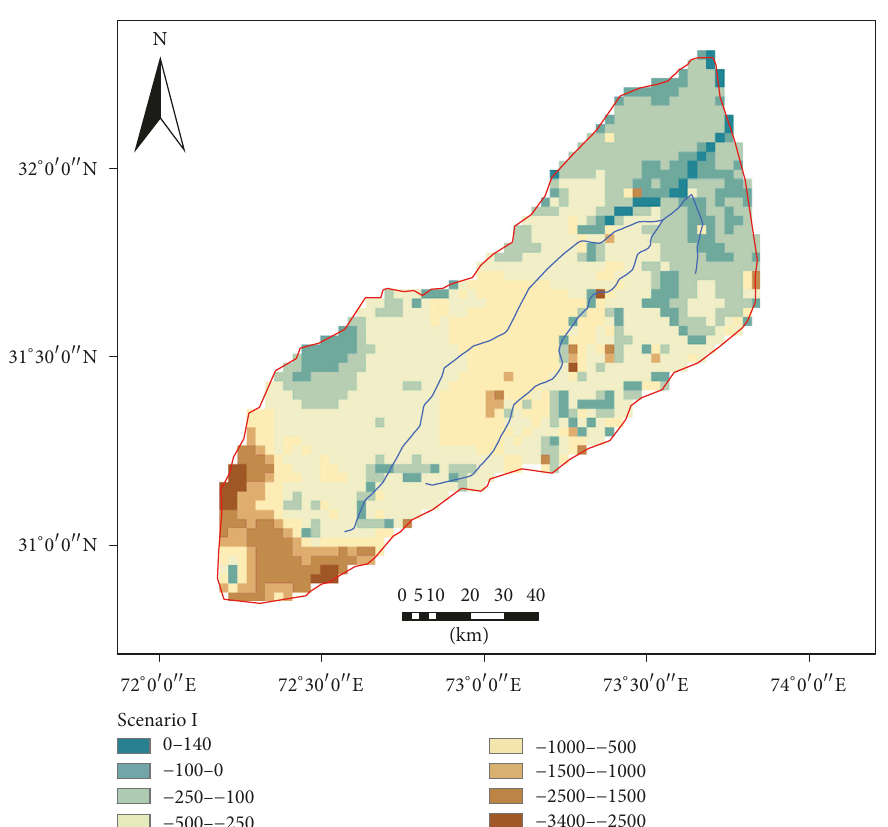
Figure 13: Change in groundwater TDS in the year 2030 (Scenario